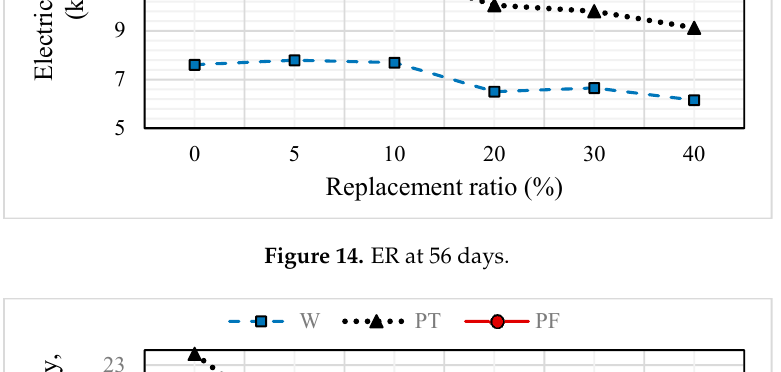
Figure14. ER at 56 days.